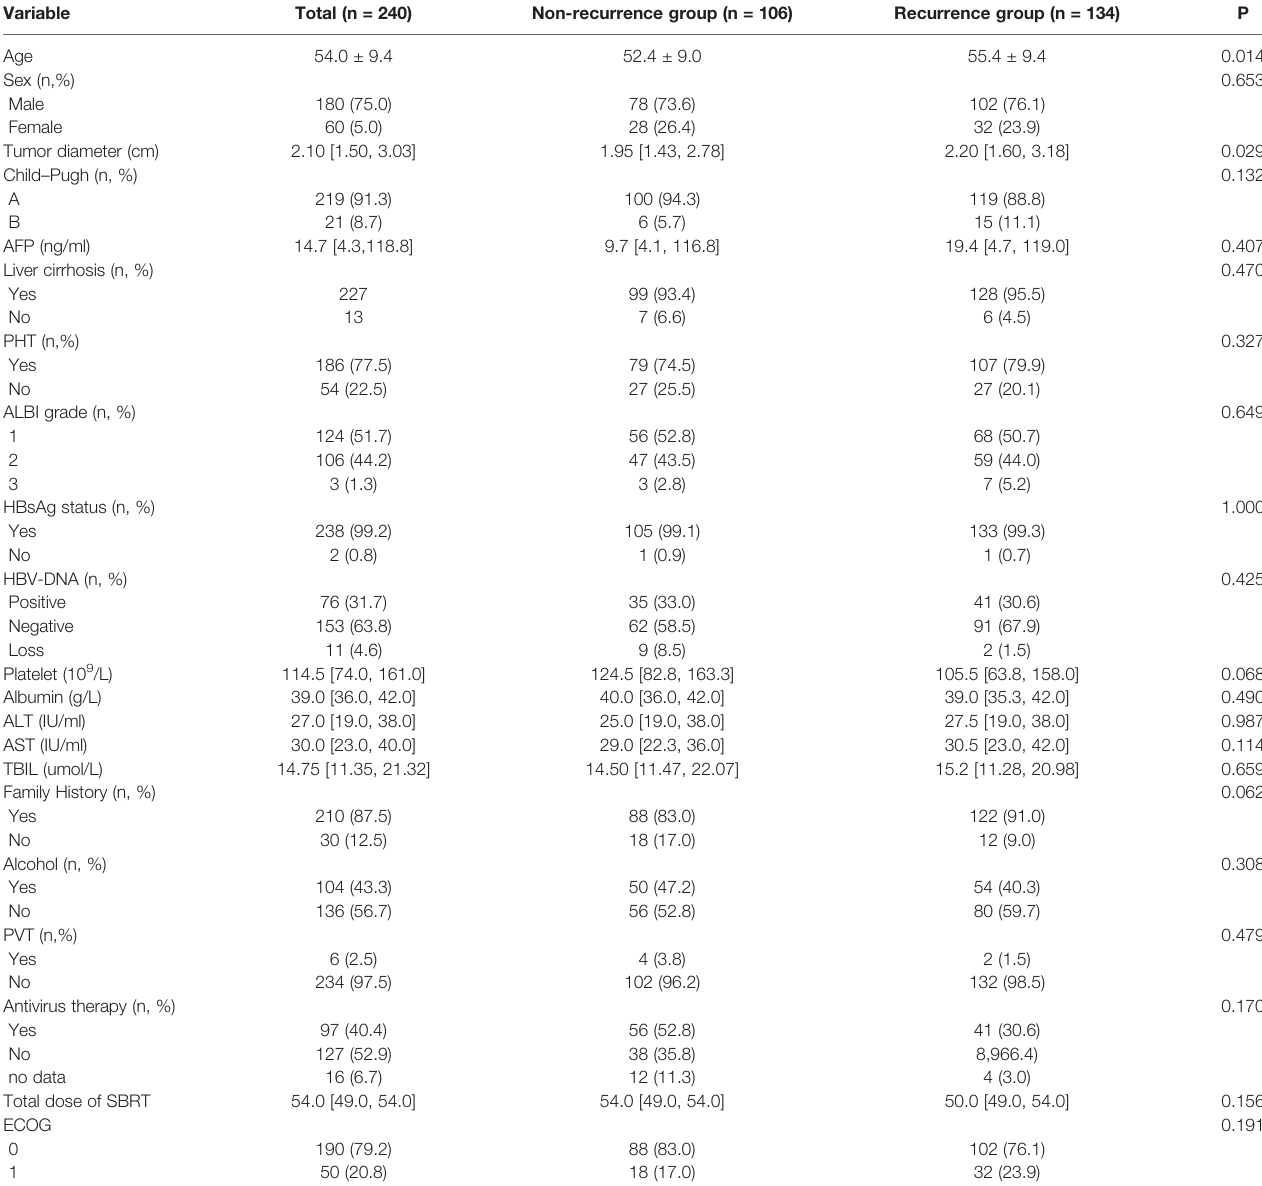
TABLE 1 | Baseline characteristics of the patients.